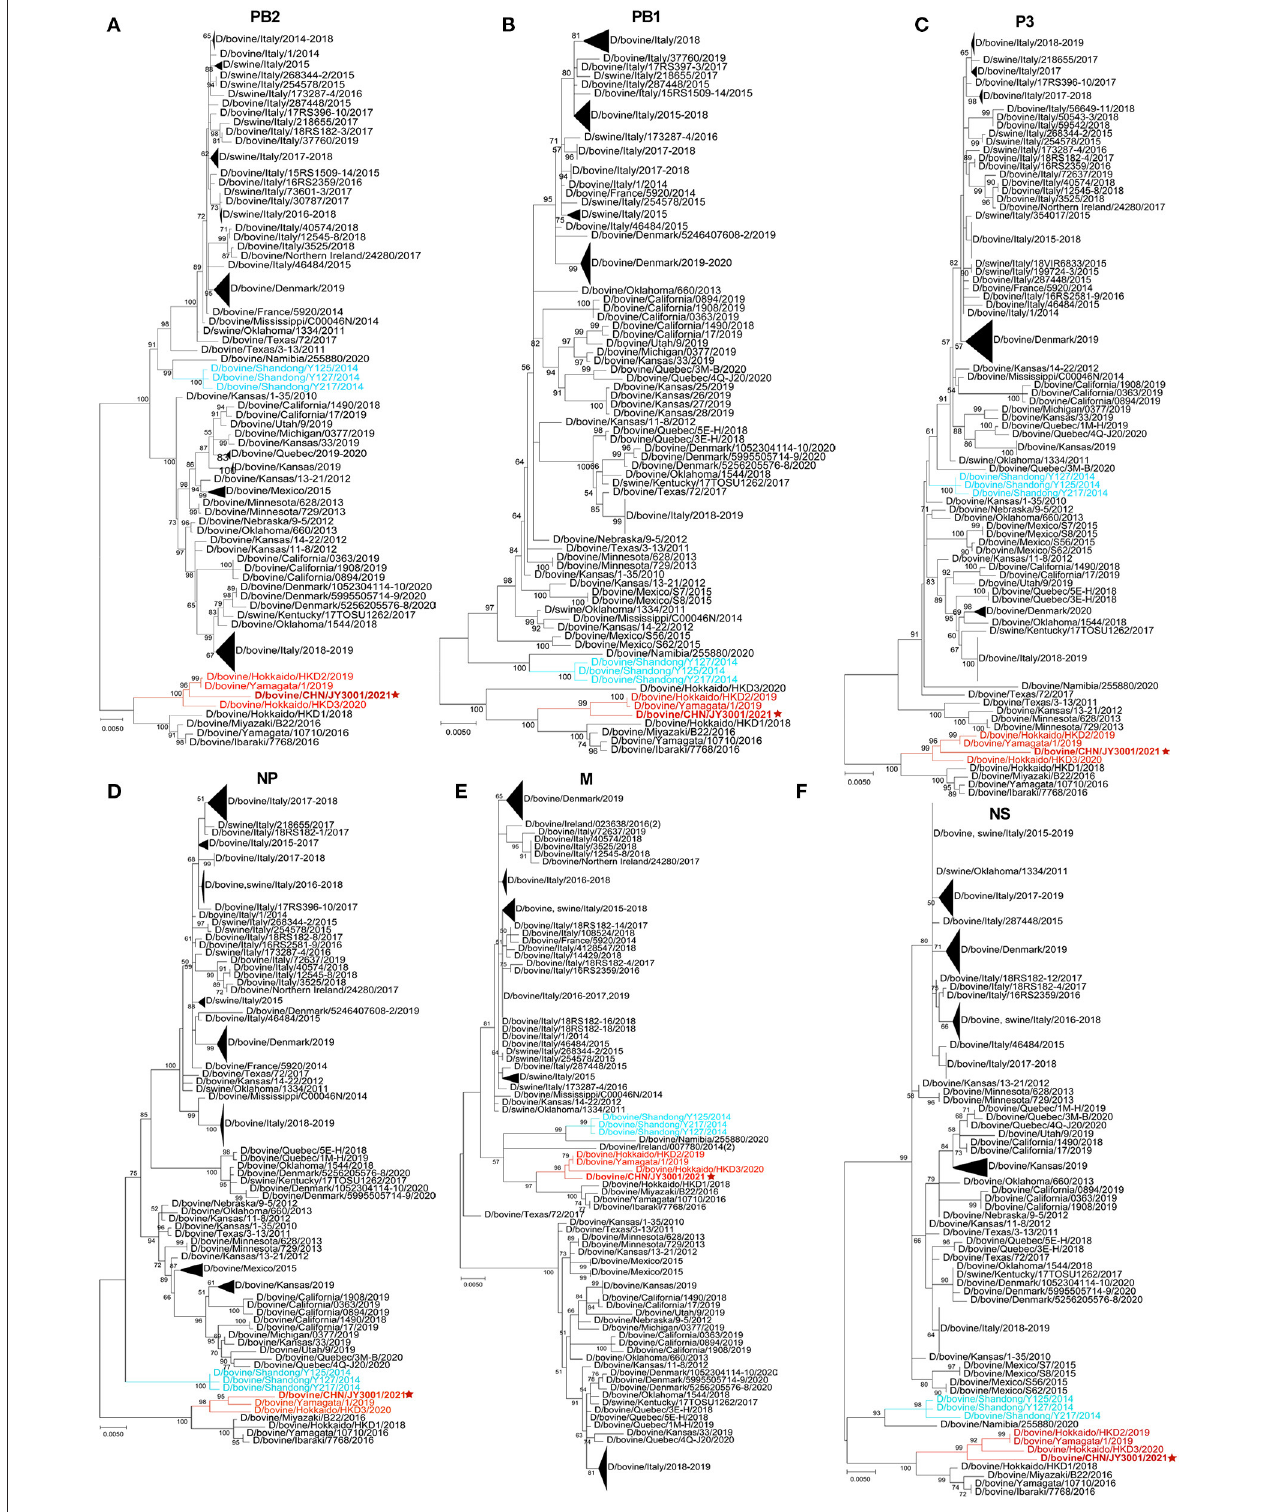
FIGURE 2 | Phylogenetic trees for non-HEF segments of IDVs. (A–F) In MEGA-X, maximum-likelihood analysis in combination with 1,000 bootstrap replicates was used to generate trees based on the nucleotide sequences of the PB2, PB1, P3, NP, M, and NS segments. Bootstrap scores of at least 50 were shown to the left of the major nodes. Scale bar represents the number of substitutions per site. The branch of D/bovine/CHN/JY3001/2021 was in red color and marked with a star. D/Yama2019 lineage-like and D/China sub lineage-like IDV strains were labeled with red and light blue colors, respectively. The D/bovine/CHN/JY3001/2021 was bolded. Triangles indicate compressed branches with virus strains isolated in the same